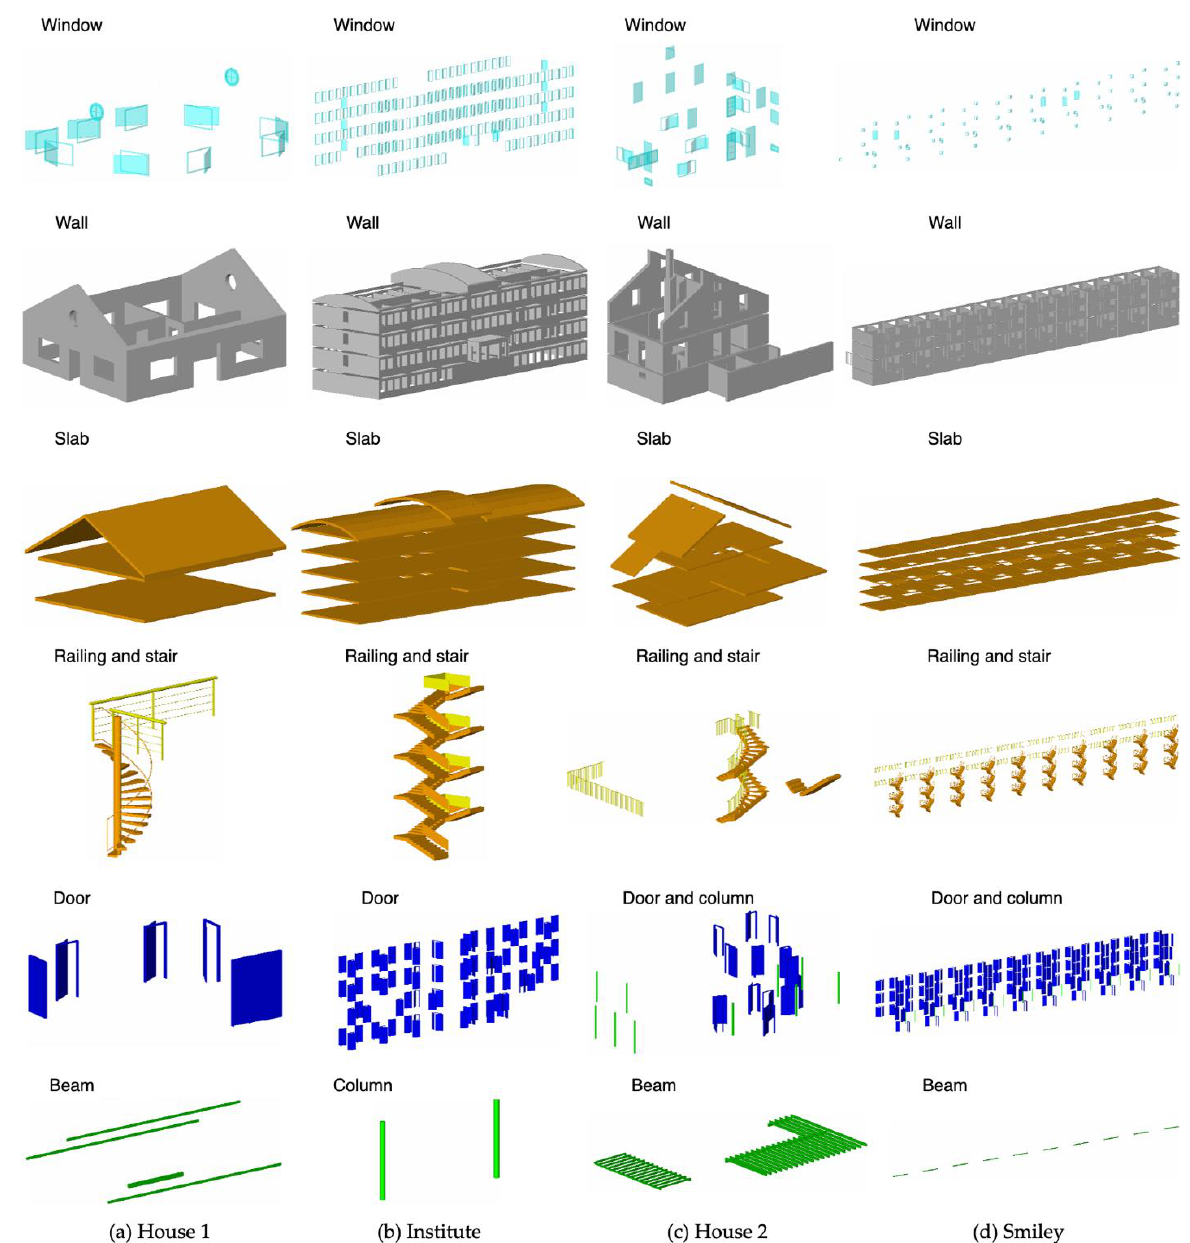
Figure 16. Building components in IFC for ( a ) House 1, ( b ) Institute, ( c ) House 2, and ( d ) Smiley.